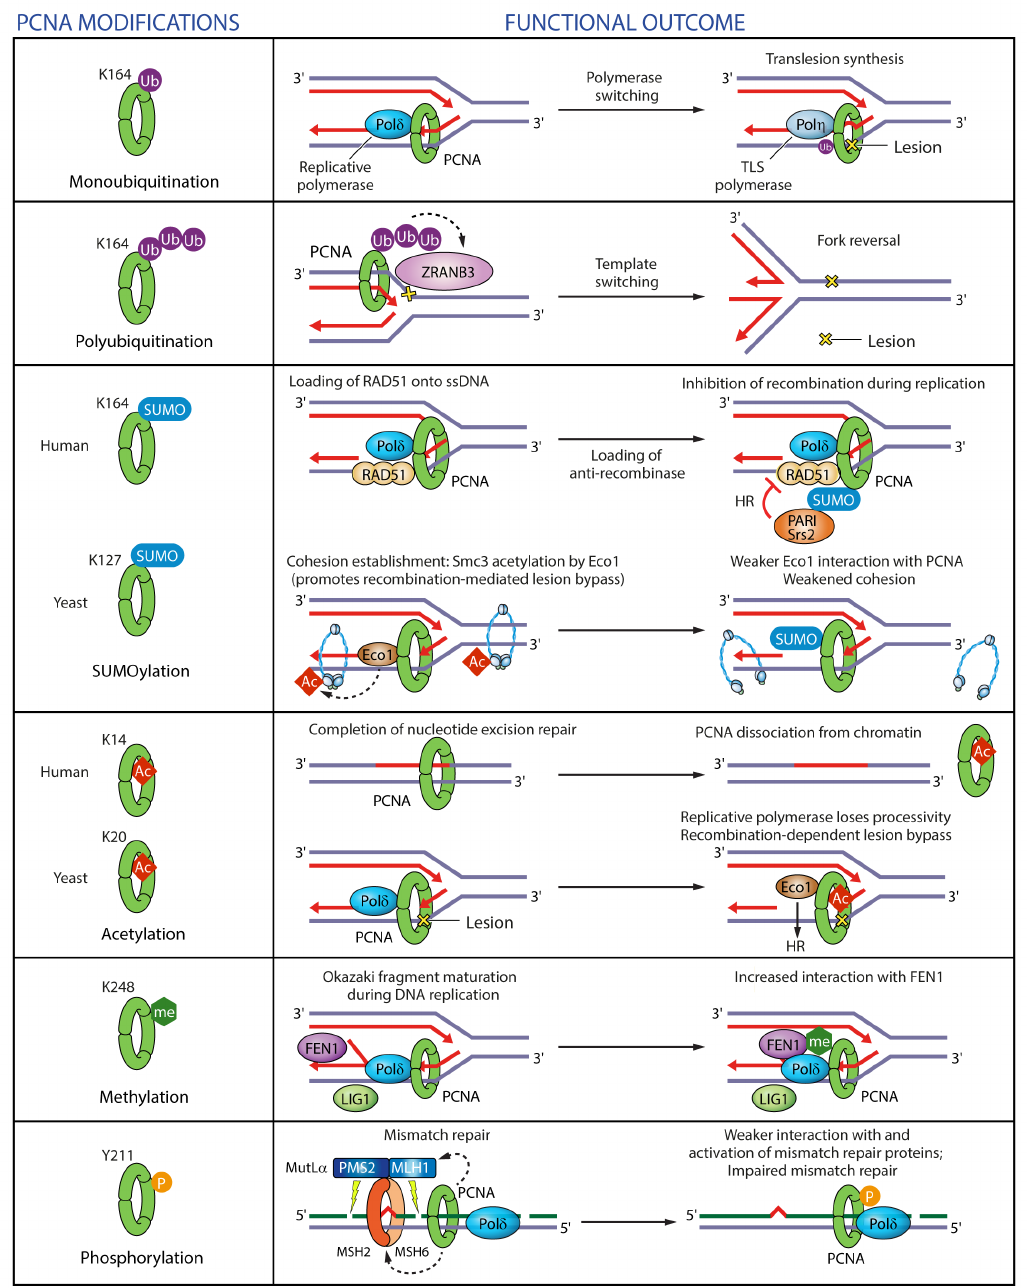
Figure 8. Regulation of PCNA functions in DNA replication and repair by post-translational modifications. PCNA monoubiquitinatation on K164 after DNA damage promotes ‘polymerase switching’, whereby stalled replicative polymerase is replaced with a specialized TLS polymerase. PCNA polyubiquitination on K164 after DNA damage triggers replication fork reversal through recruitment of ZRANB3 translocase/structure-specific endonuclease. PCNA SUMOylation on K164 recruits anti-recombinases PCNA-interacting protein (PARI) or Srs2 in human cells and yeast respectively to prevent recombination during replication. PCNA SUMOylation on K127 in yeast weakens the interaction of the acetyl transferase Eco1 with PCNA, which in turn impairs cohesion establishment. PCNA acetylation on K14 in human cells facilitates PCNA dissociation upon completion of DNA repair. PCNA acetylation on K20 in yeast reduces the processivity of Pol δ and promotes homologous recombination. PCNA methylation on K248 enhances its interaction with FEN1. PCNA phosphorylation on Y211 weakens its interaction with mismatch repair proteins.